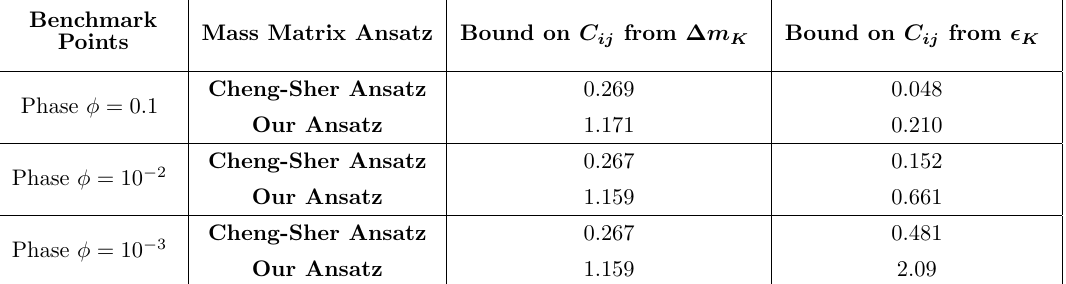
Table 2 . Upper bound on the coe(cid:14)cients C ds from K 0 (cid:0) K 0 mixing and measurement of CP violation parameter j (cid:15) K j . Here we choose Y ij = Y ? factor m d changed to